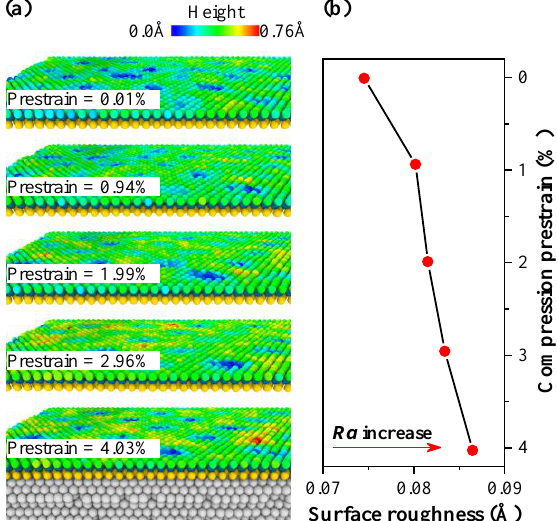
Figure 2. After relaxation process, ( a ) atomic morphology of monolayer MoS 2 (color symbolizing the atomic heights of S layer on the top). ( b ) Surface roughness of the monolayer MoS 2 under different compressive prestrain conditions.